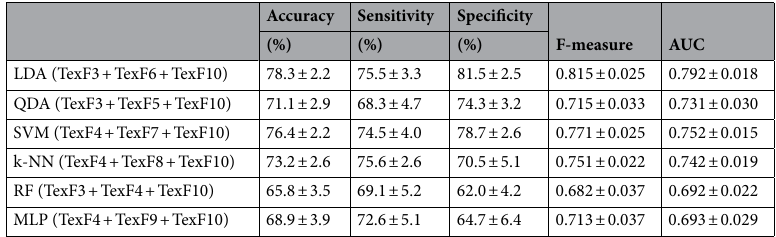
Table 6. Performance of machine learning–based classifications of anti-ARS-antibodies. Note Data are means ± standard deviations. Feature name codes are as follows: TexF1 = kurtosis, TexF2 = interquartile range, TexF3 = total energy, TexF4 = cluster prominence, TexF5 = correlation, TexF6 = difference average, TexF7 = imc2, TexF8 = maximum probability, TexF9 = large dependence high gray-level emphasis, TexF10 = dependence non- uniformity, TexF11 = coarseness. LDA linear discriminant analysis, QDA quadratic discriminant analysis, SVM support vector machine, k-NN k-nearest neighbors classifier, RF random forest classifier, MLP multi-layer